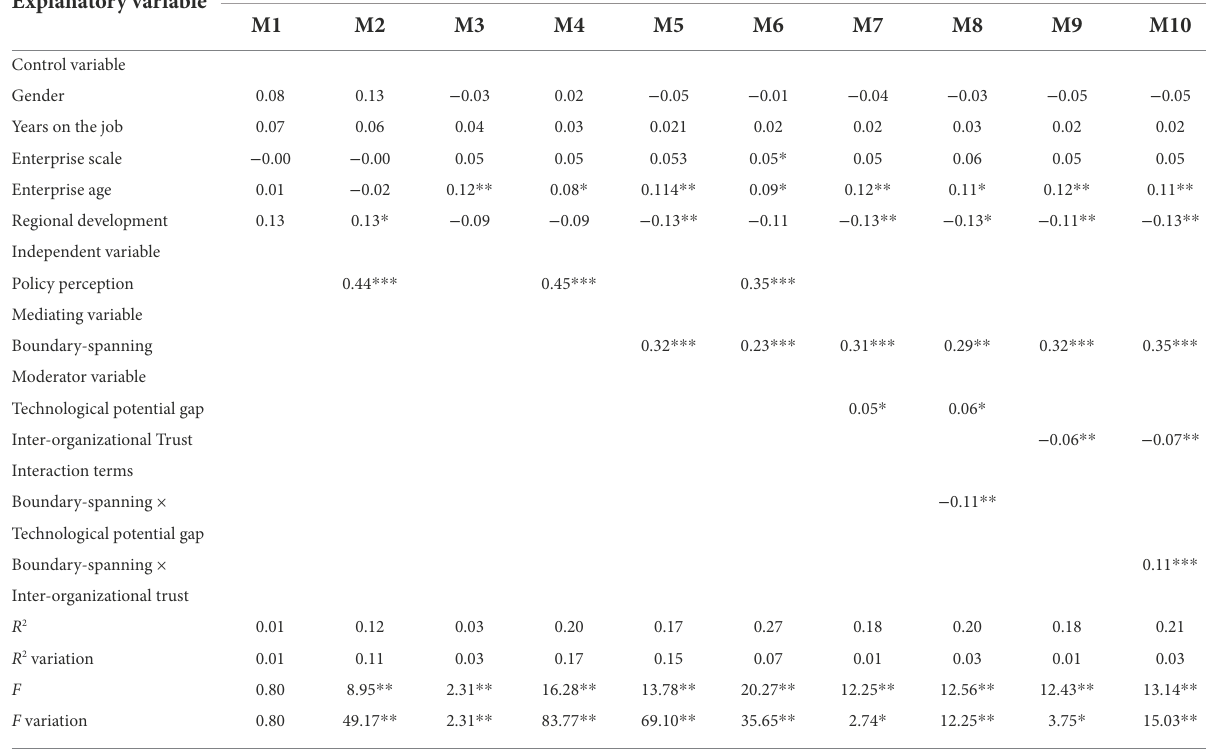
TABLE 5 Hierarchical regression